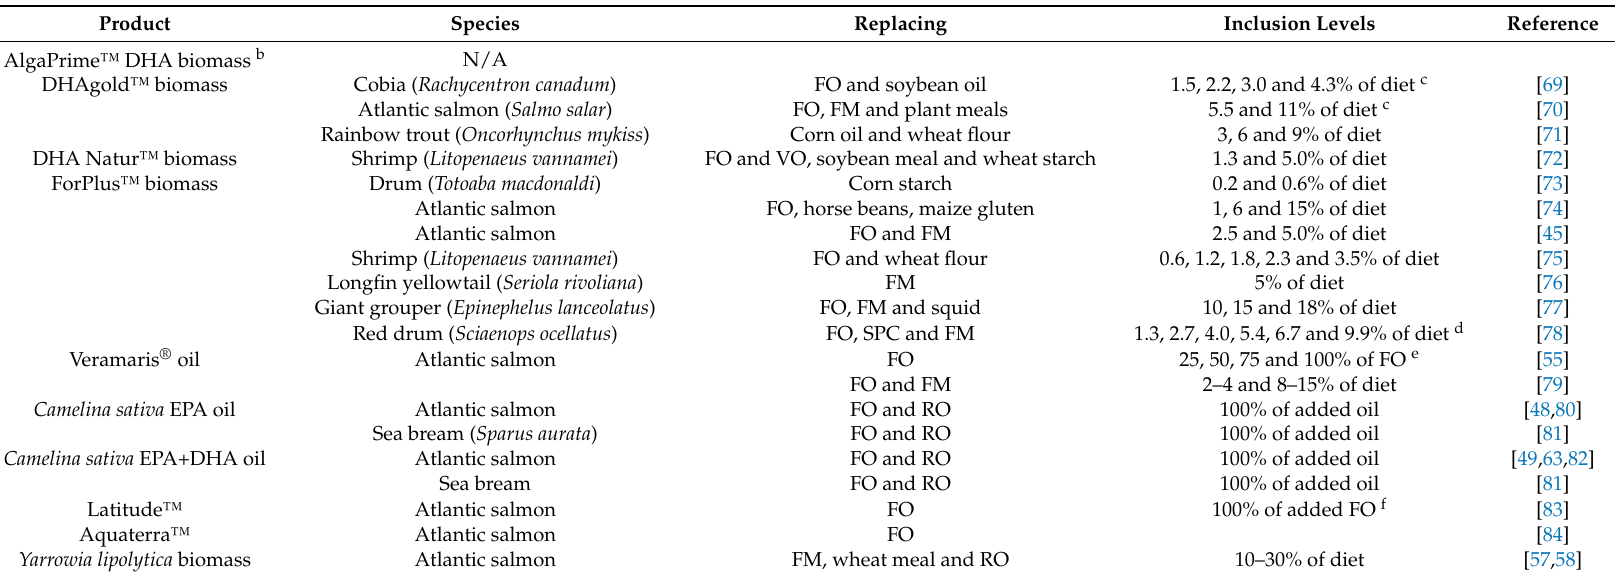
Table 2. Studies using the products listed in Table 1, or similar, related materials tested as part of the development process, as ingredients in feeds for fish a